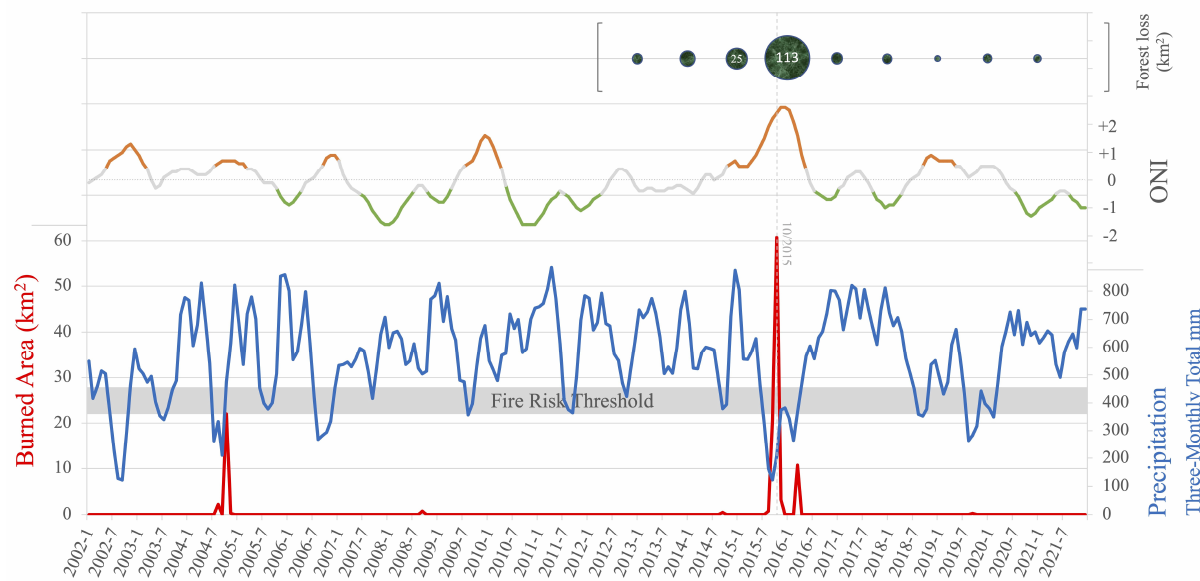
Figure 7. Estimates of monthly burned area (MCD64A1) and three-monthly total precipitation (CHIRPS) within Kutai National Park, as well as the Oceanic Niño Index (ONI) between 2002–2021, with phases of El Niño in orange and La Niña in green. Green bubbles (top) represent annual estimates of forest loss within KNP (HGFC v1.9) between 2013–2021 in square kilometers (aligned to Jan 1 of the detection year). The reported fire risk threshold for this region of 4–5 mm/day (360–450 mm/3 month period) is denoted by the grey